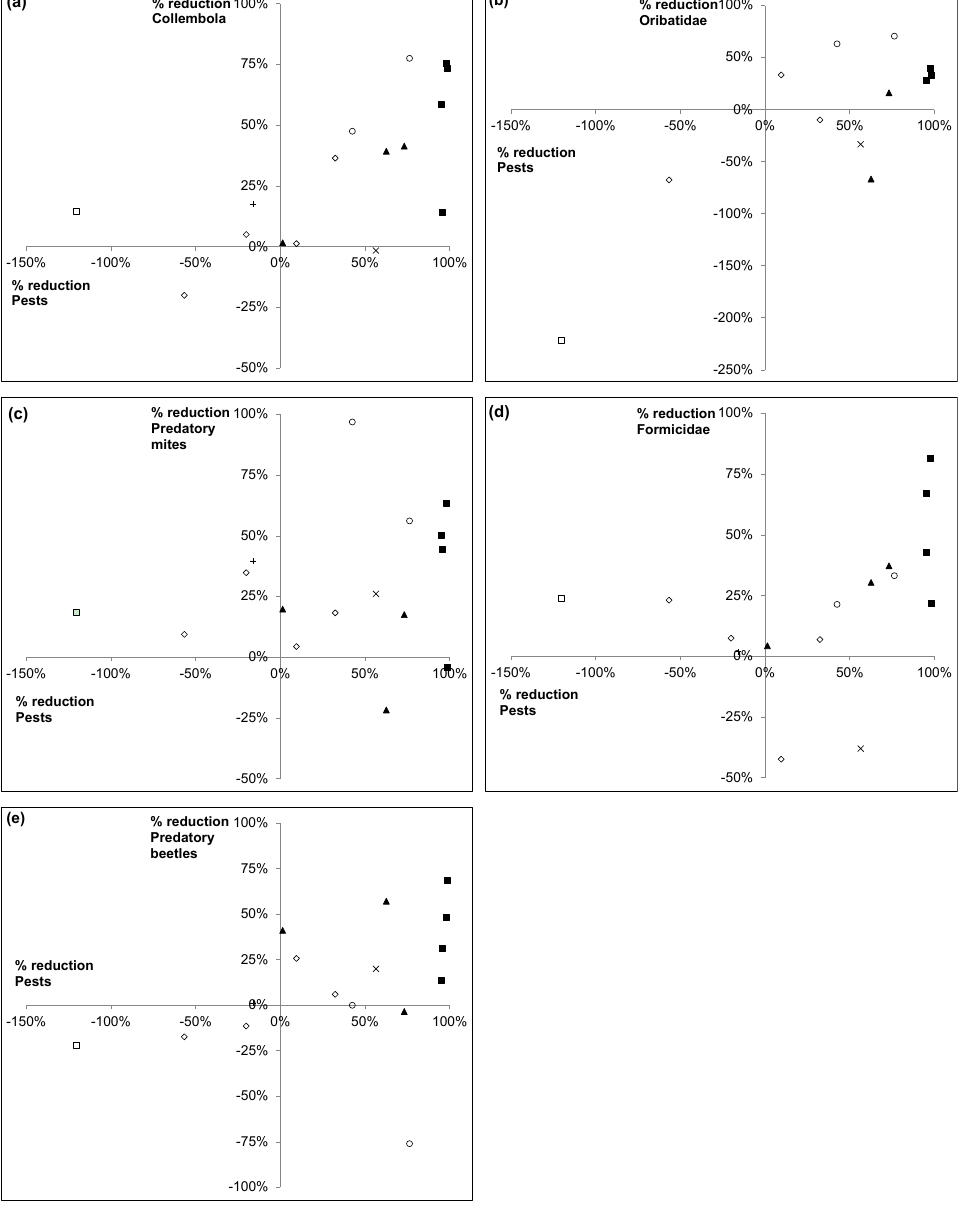
Figure 4. Percentage reduction of pest numbers ( H. destructor and Penthaleus spp.) relative to reductions in ( a ) Collembola, ( b ) Oribatidae, ( c ) Predatory mites, ( d ) Formicidae and ( e ) Predatory beetles after exposure to broad-spectrums ( ■ ), diafenthiuron (  ), thiamethoxam/abamectin ( ▲ ), dimethoate (  ), imidacloprid ( ◇ ), spinosad (  ) and paraffinic oil ( 